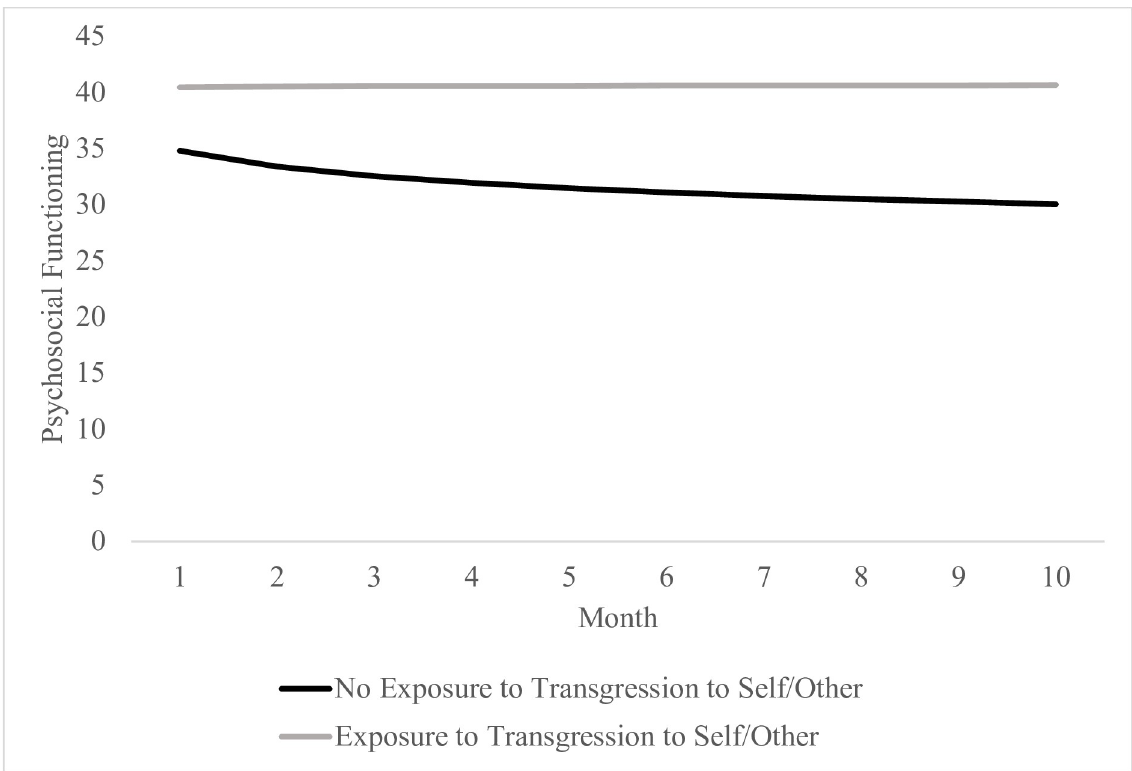
Fig 2. Logarithmic change in psychosocial functioning over the course of 10 months during the COVID-19 pandemic based on transgression to self or other exposure.